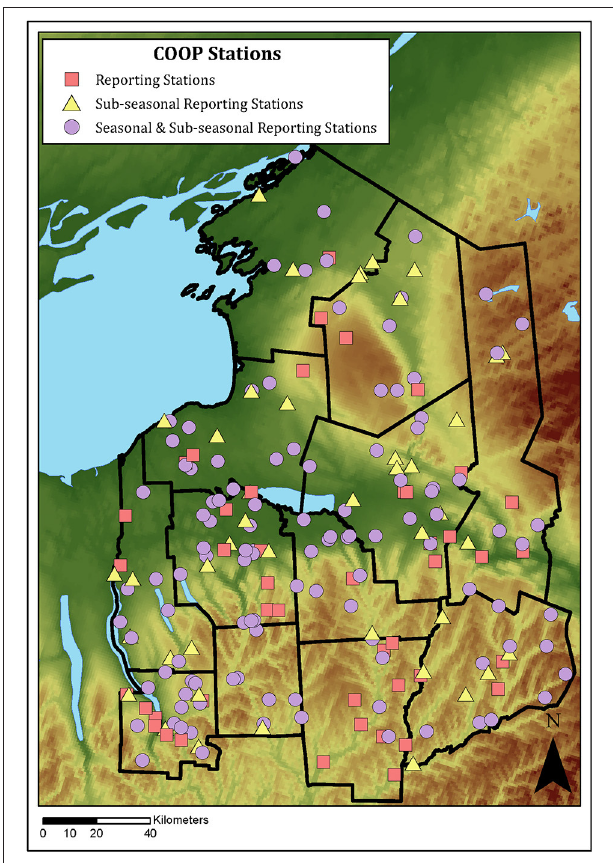
FIGURE 2 | COOP stations used for analysis in Central New York. Included are the 202 COOP stations reporting from 1995/96 to 2014/15 (“Reporting Stations”), 155 stations used for the sub-seasonal analysis (“Sub-seasonal Reporting Stations”), and the 111 stations used for seasonal analyses (“Seasonal and Sub-seasonal Reporting